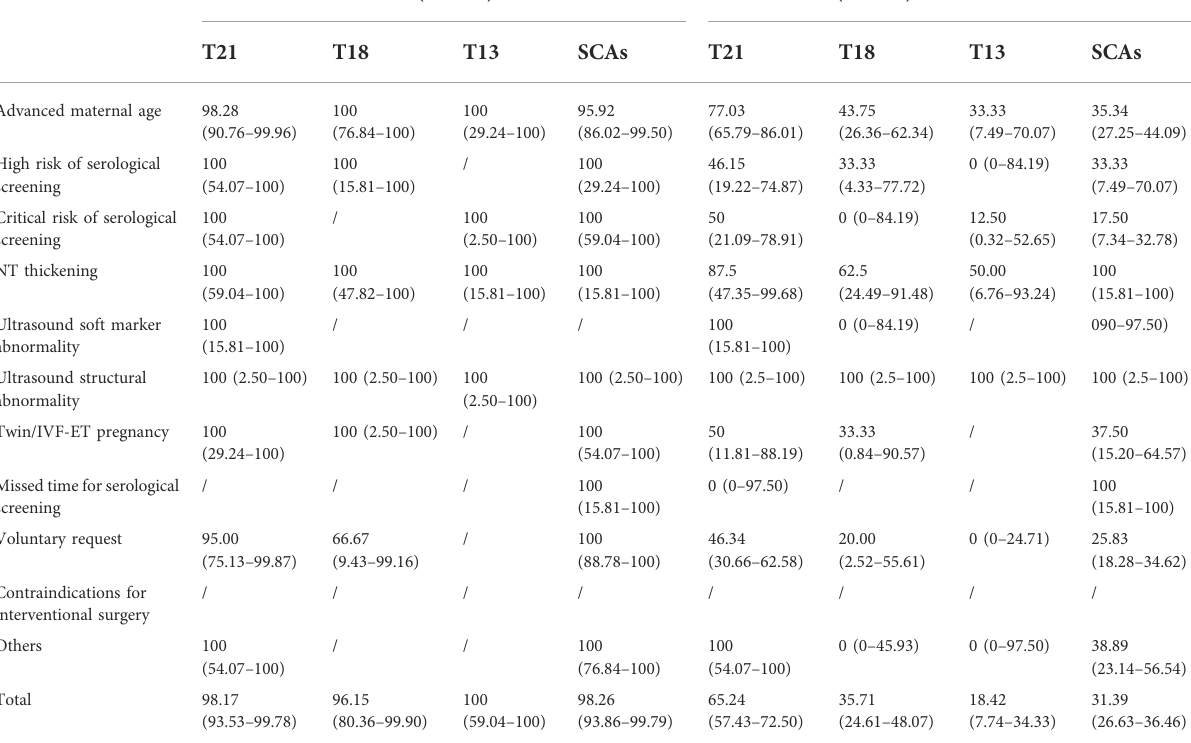
TABLE 5 Aneuploidy detection rates according to NIPT screening